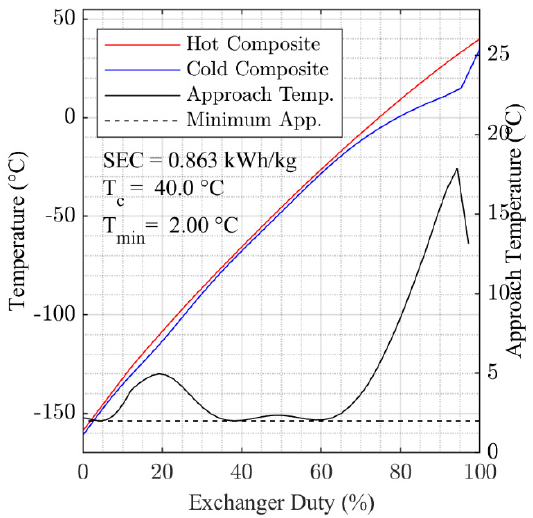
Figure A8. Optimized composite cooling curves for 40 ◦ C cooling temperature.